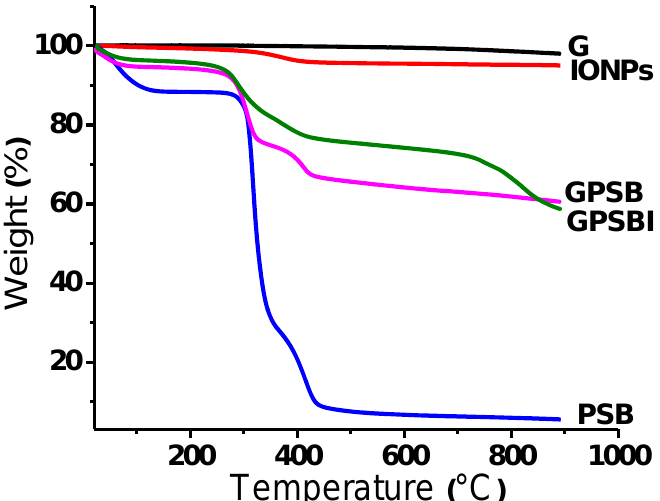
Figure 7. TGA thermograms of G, IONPs, GPSB, GPSBI, and PSB.